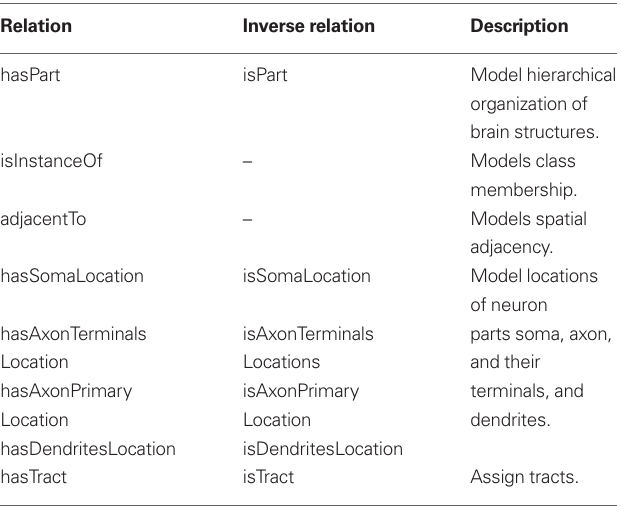
Table 1 | The most important relations used in our bee brain ontology to describe spatial, morphological and, connectional